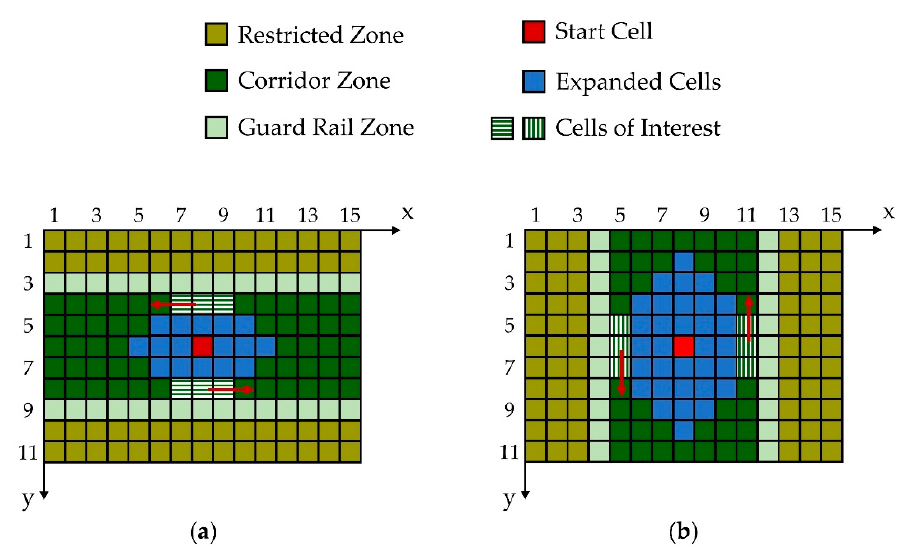
Figure 5. Exemplary planning scenario. ( a ) Horizontal; ( b )